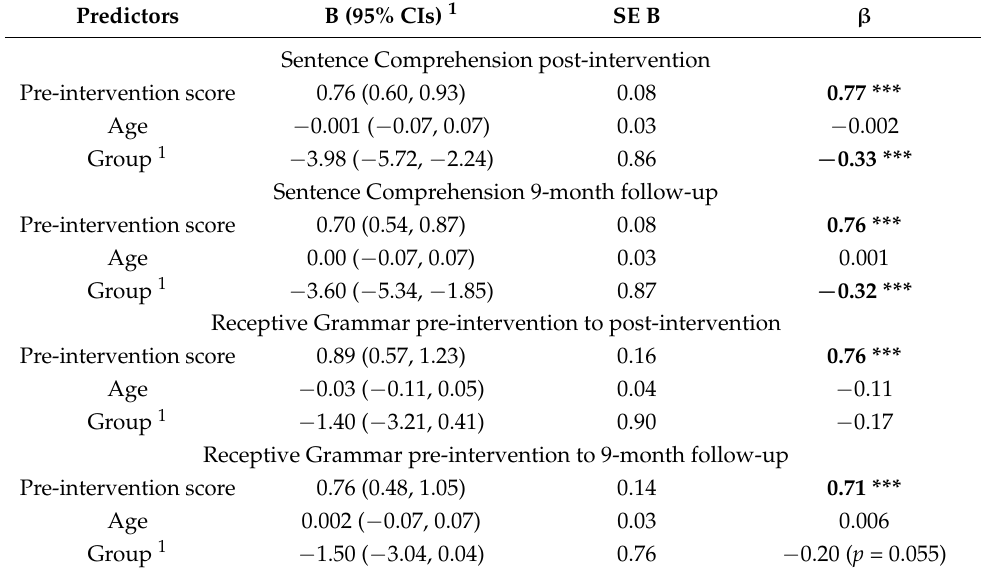
Table 4. Summary of step 2 of the regressions for the far-transfer outcome variables (ACE Sentence Comprehension and TROG-2 Receptive